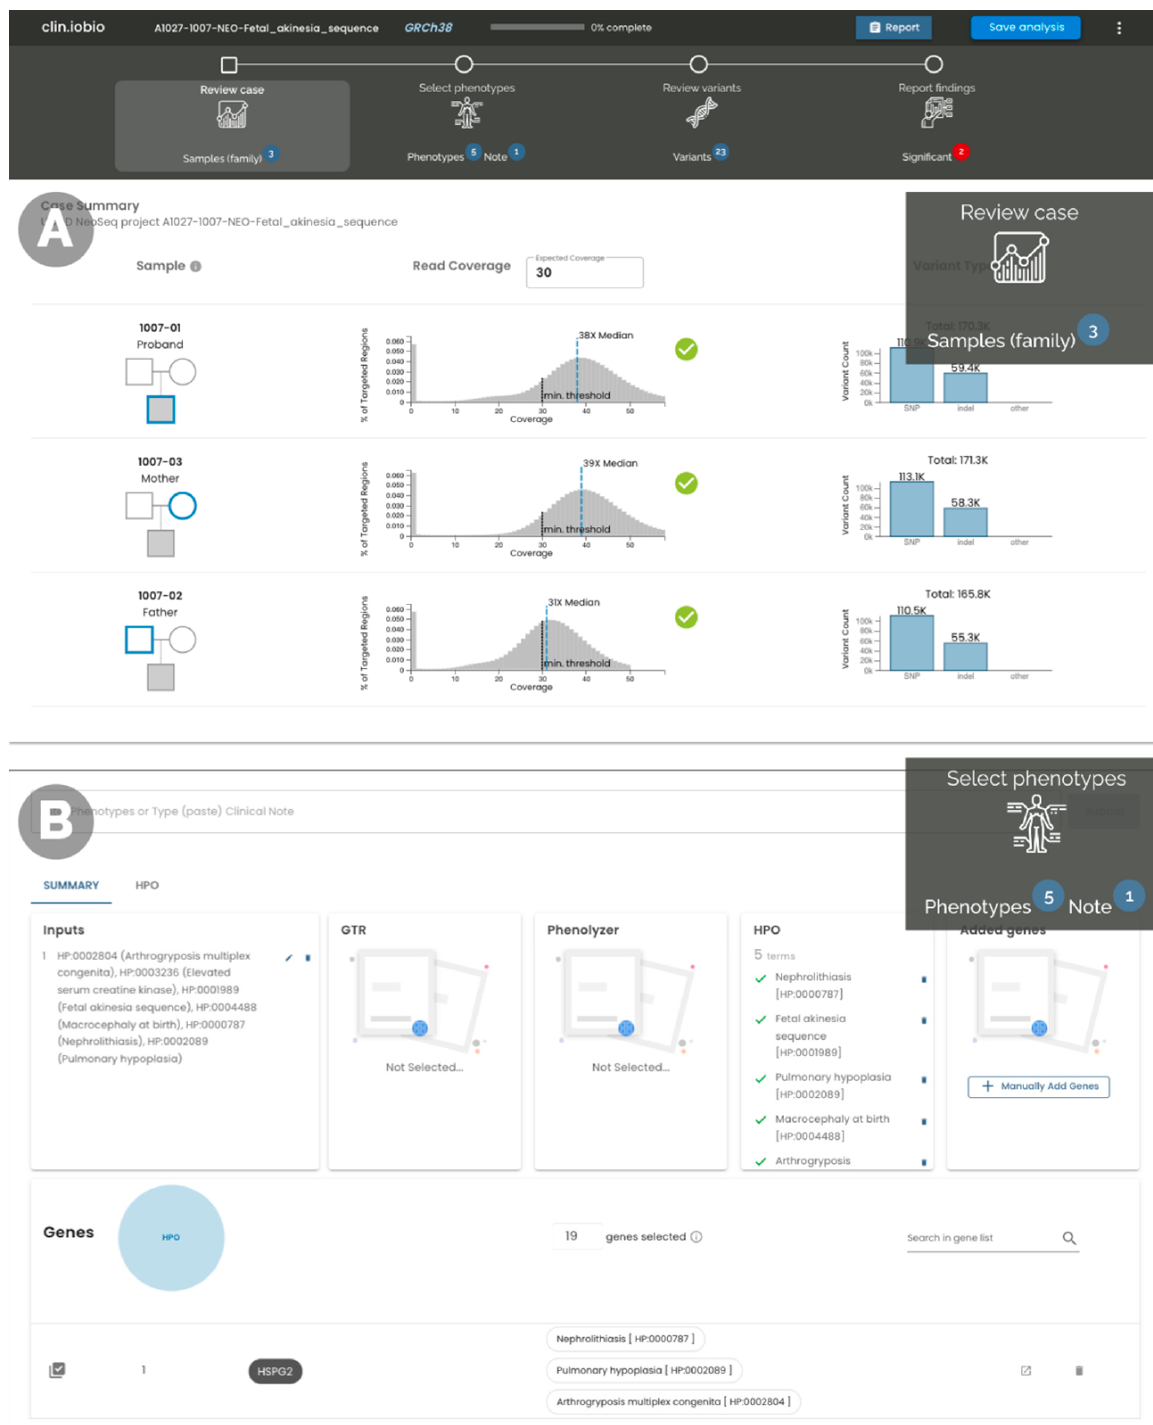
Figure 1. The first two steps in the clin.iobio web app, with the workflow shown at the top of the figure. This workflow is always present at the top of the page, with step-specific information (e.g., the number of identified significant variants) shown with each task. This workflow is not linear; rather, users can jump to whichever step they desire. ( A ) Basic overall quality control metrics for the patient and family members show that sequencing coverage has expected distributions, with median coverages above the required threshold. ( B ) A candidate gene list is generated and refined based on patient phenotypes. Here, a set of HPO terms was selected, and interactive charts limit the list to genes that are associated with at least 3 HPO